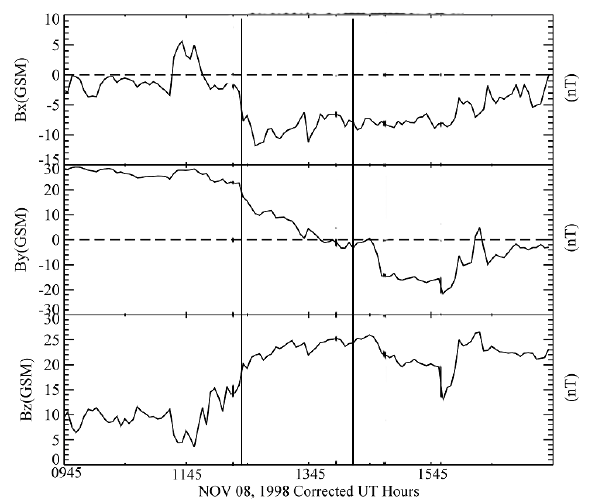
Figure 5. Magnetic field data are shown from the ACE satellite which orbits the L1 Lagrangian point about 220 R E sunward of the Earth . IMF GSM components are plotted for November 8, 1998, as a function of corrected universal time (UT plus the estimated propagation time from the satellite to GSM X=0); about 45 min. The two cases studied correspond to the times marked by thin vertical lines.